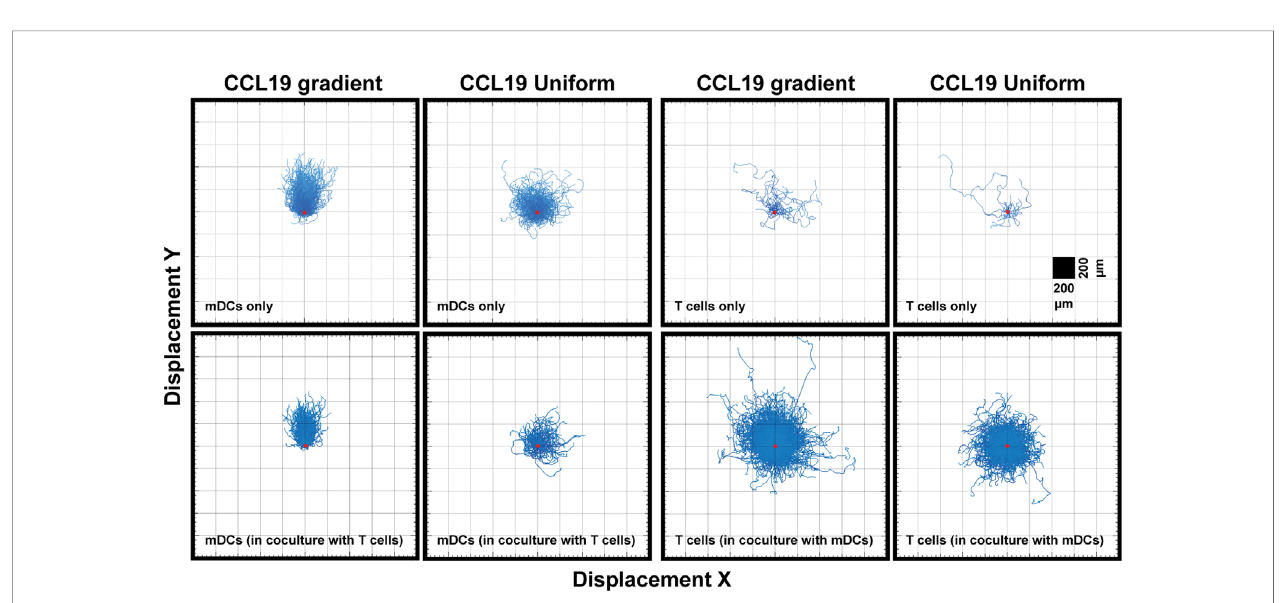
FIGURE 3 | Unlike DCs, T cells do not show a strong chemotactic response to a CCL19 gradient. "Spider plots" showing the tracks of mDCs and T cells over time in response to a CCL19 gradient or a uniform 100 ng mL -1 CCL 19 concentration plotted from a single origin point (red dot). All data is from one representative experiment that was repeated at least three